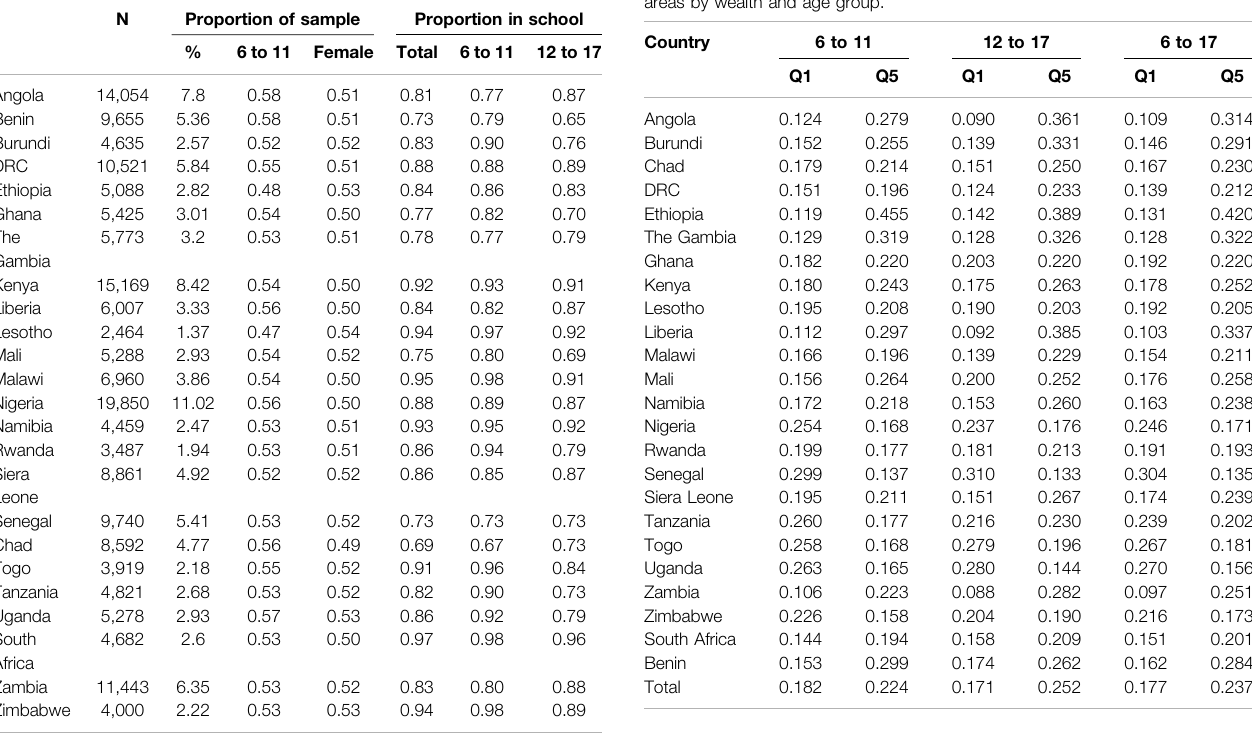
TABLE 1 | Background characteristics of the study sample. TABLE 2 | Proportion of population of school going aged children living in urban